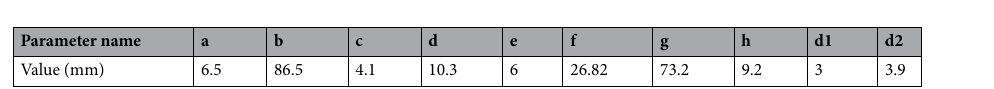
Table 1. Optimum values of design parameters of the wideband coaxial-to-waveguide transition.